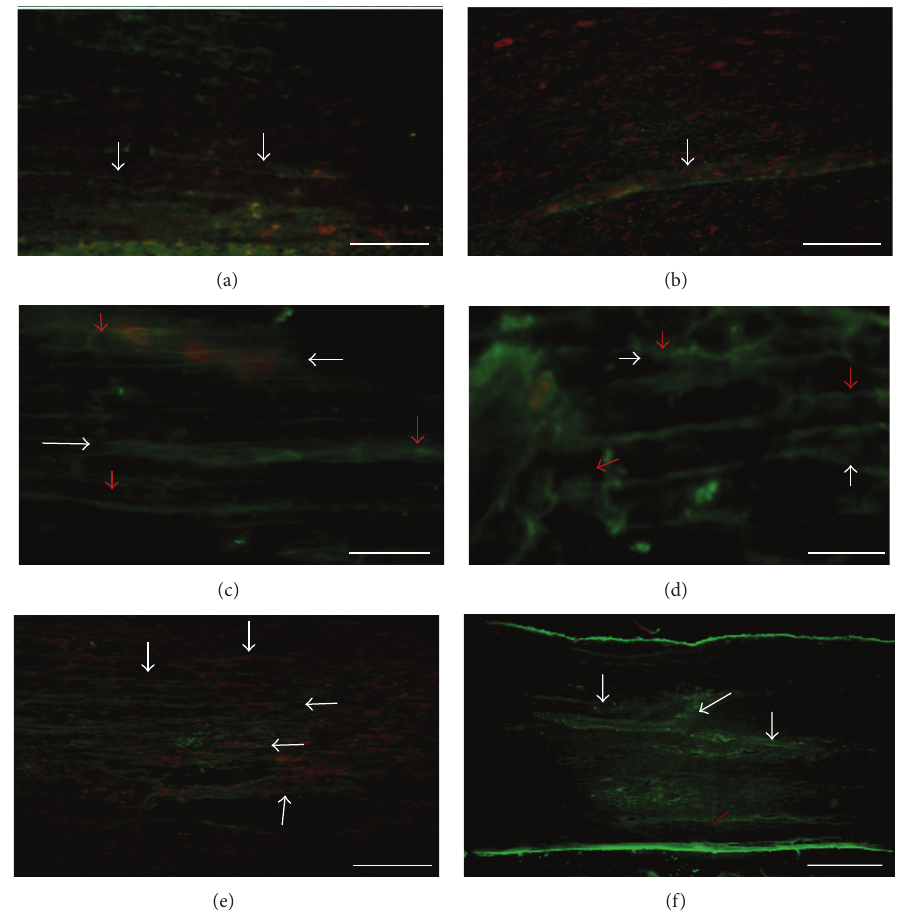
Figure 4: Photomicrography of the expression of Neuritin in spinal cord. (a) Control group. (b) Fibrin glue group (FG). (c) PPN group, rostral zone of the SC. (d) PPN + BMSCs group, rostral zone of the SC. (e) PPN group, caudal zone of the SC. (f) PPN + BMSCs group, caudal zone of the SC. A greater quantity of Neuritin positive fibers can be observed in panels (c) to (f) (white arrows, Alexa 488, green color), compared to panels (a) and (b). We can also observe that growth cones (red arrows) were only presented in the treated groups (panels (c) and (d)). All the tissue was contrasted with propidium iodide (nuclei red color). Calibration bar 20 𝜇